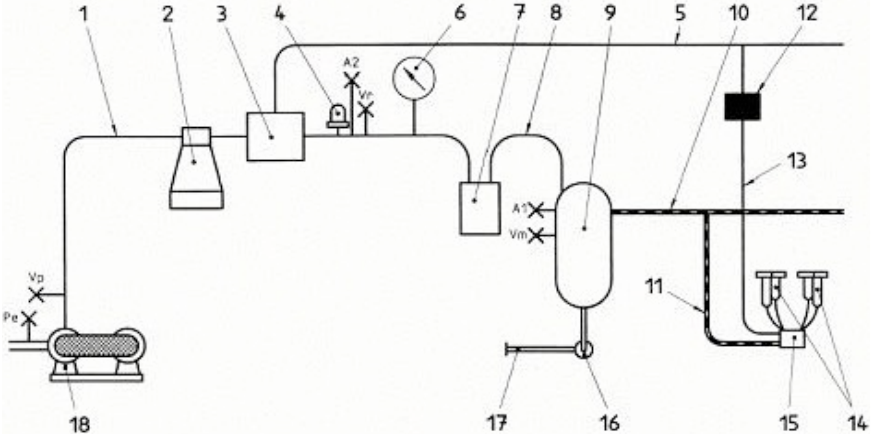
Figure 1. Example of a pipeline milking machine. (extracted from ISO